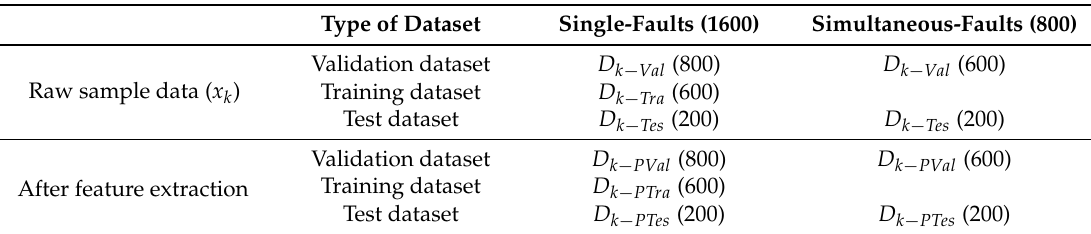
Table 6. Division of sample dataset into different